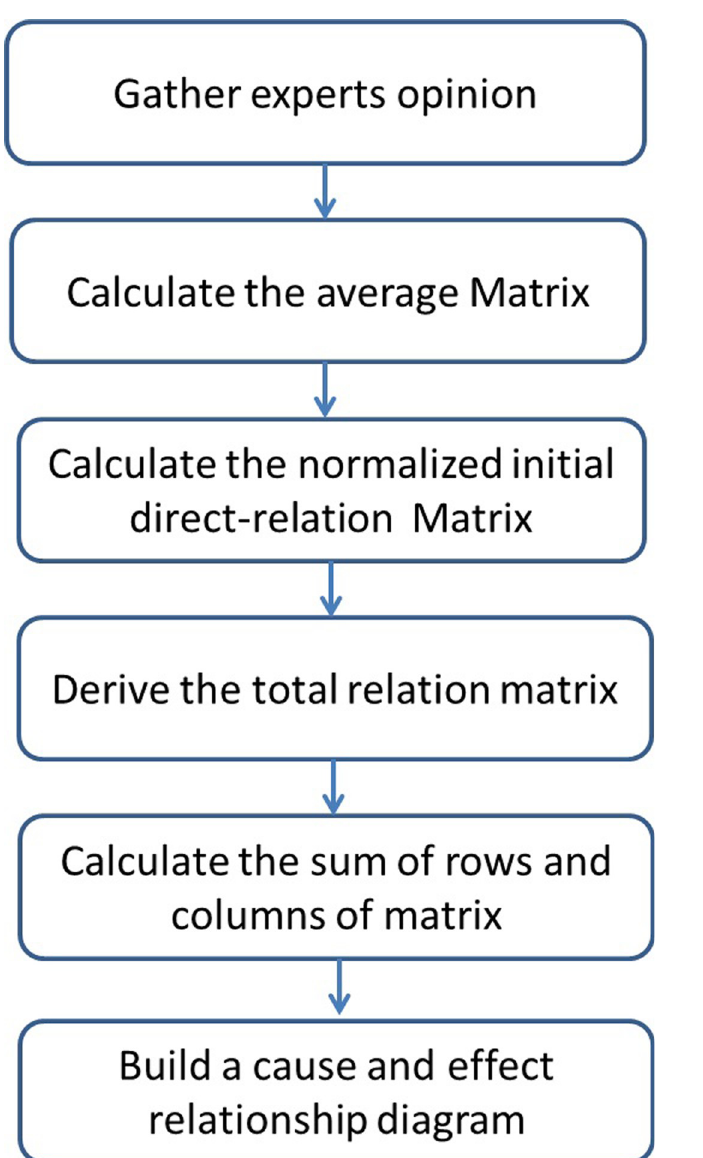
Fig 1. The process of the DEMATEL